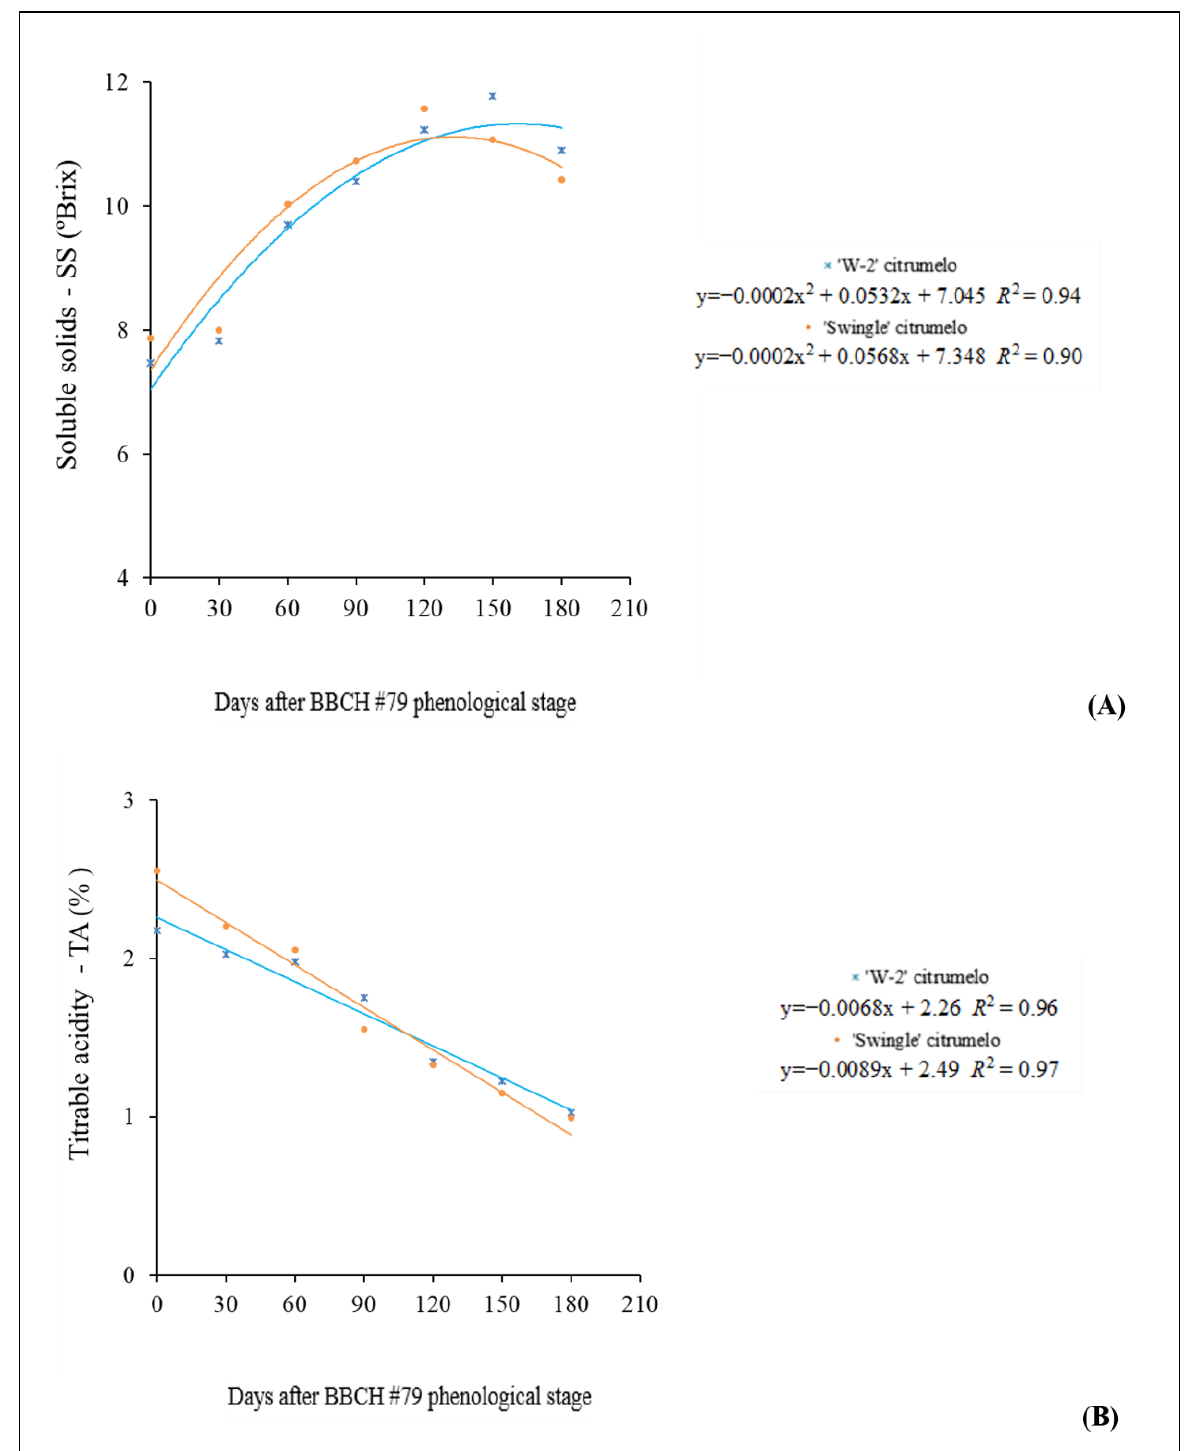
Figure 6. Development of ‘Valencia’ orange fruit ripening when trees are grafted on different ‘Trifoliata’ hybrid rootstocks at São Jerônimo da Serra. ( A ): soluble solids (SS as ◦ Brix); ( B ): titratable acidity (TA as %). Phenological stage BBCH #79 (Meier, 2001), approximately to 200 days after flowering.